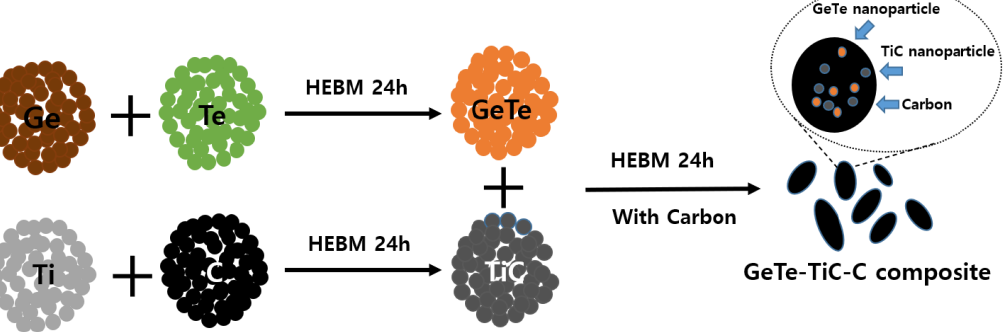
Figure 1. Schematic for the formation of GeTe-TiC-C composite.